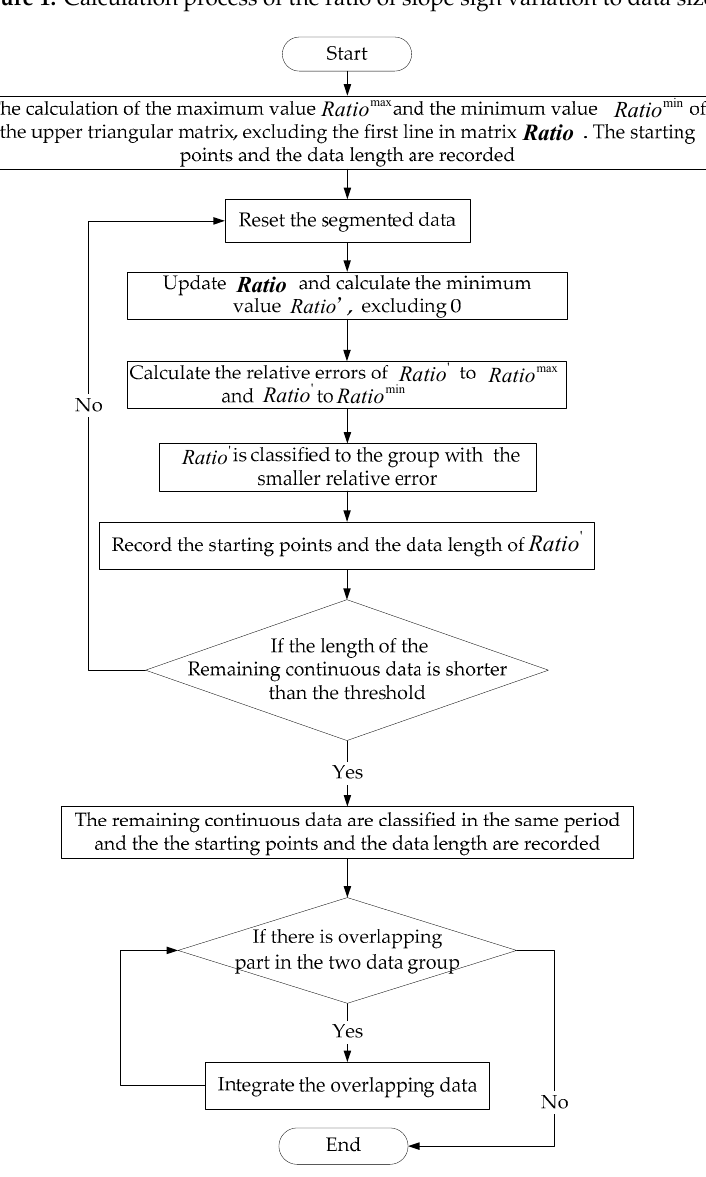
Figure 1. Calculation process of the ratio of slope sign variation to data size. Energies 2020 , 13 , x